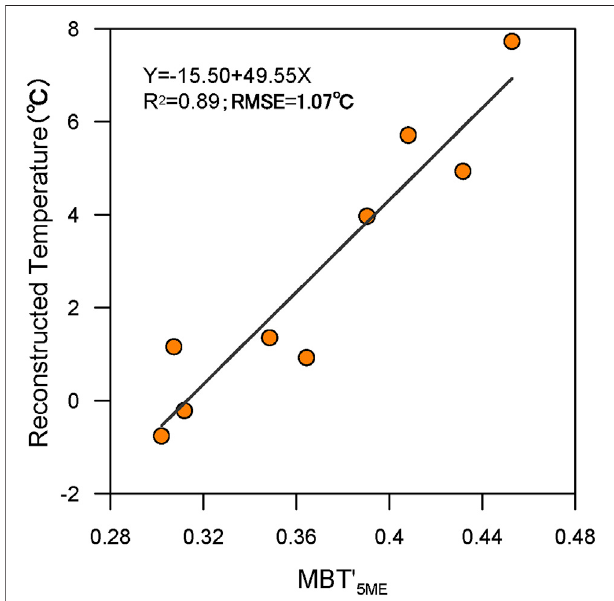
FIGURE 5 | Reconstructed Qilian Shan soil temperatures based on MBT ′ 5ME .